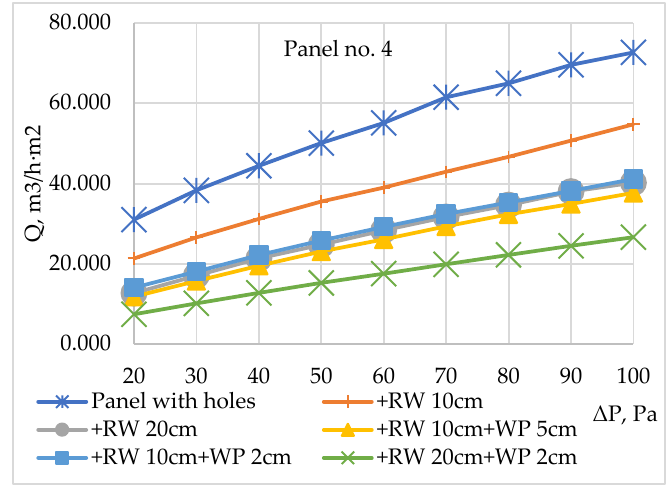
Figure 9. Panel no. 4: air permeability dependence on pressure difference when various insulation variants were applied. Table 3. Calculated and measured values of construction air permeability at 50 Pa pressure di ff erence. Panel No. Q, m 3 / h · m